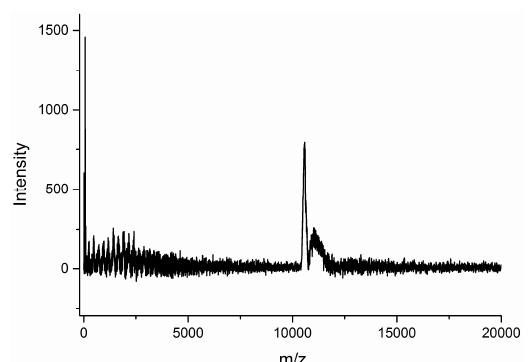
Figure 2. Maldi ‐ TOF spectrum of dried products from a xylene/water emulsion containing a 1:1 weight ratio of tung oil and asolectin subjected to 24 h heating at 100 °C in the presence of di ‐ tert ‐ butyl peroxide